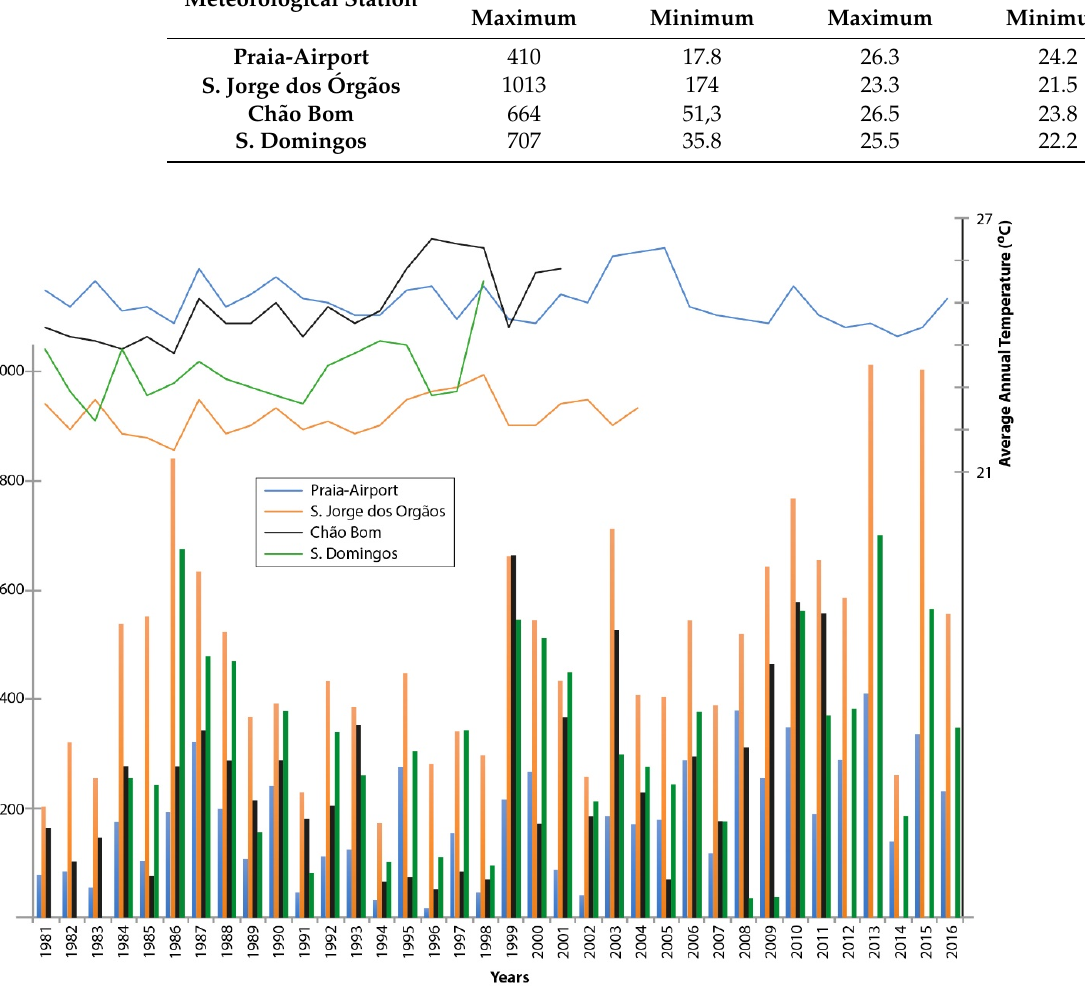
Figure 5. Distributions of average annual precipitation (1990 to 2016) and of average annual temperature (1981 to 2016) in Santiago Island (data provided by INMG—Instituto Nacional de Meteorologia e Geofísica de Cabo Verde).